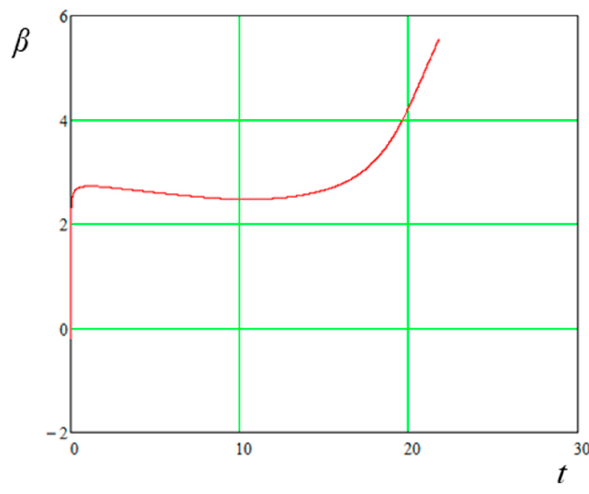
Figure 5. Changing the polar angle β along the transfer trajectory as a function of flight time [un- dim.].